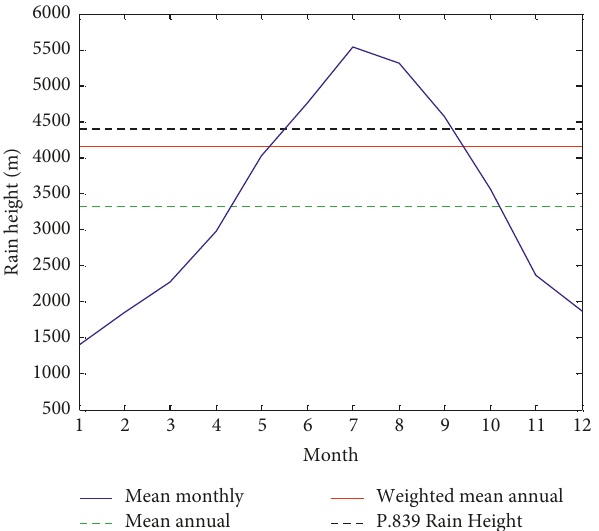
Figure 4: Comparison between different mean rain heights in Suzhou, China.